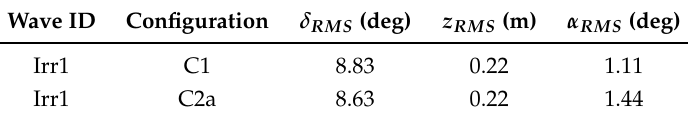
Figure 19. PSD of the pitch motion. Table 10. RMS values of the floater motion in irregular